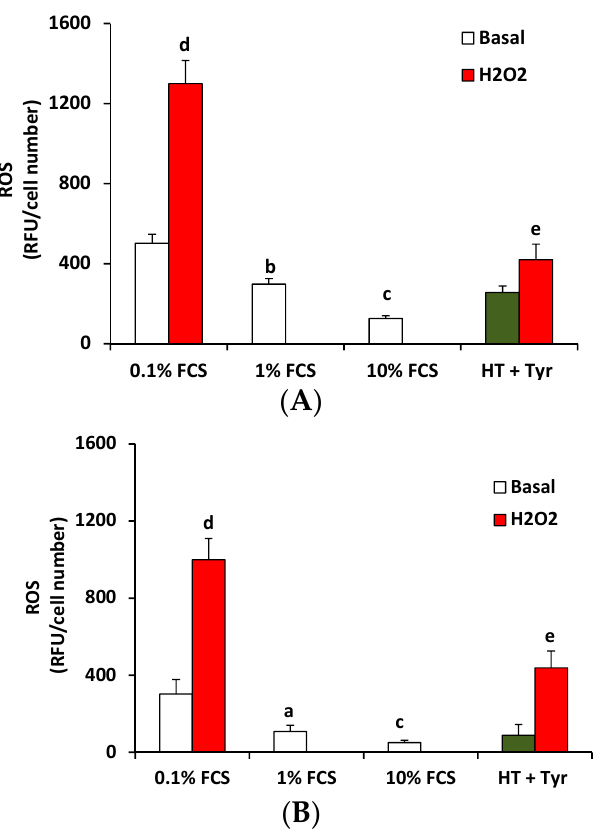
Figure 3. The HT + Tyr combination decreases reactive oxygen species (ROS) levels in HUVEC exposed to H 2 O 2 . HUVEC were stimulated with HT + Tyr (10 µM each, green bar) in 0.1% FCS for ( A ) 30 min or ( B ) 18 h and then exposed to H 2 O 2 (100 µM, 90 min). Data are expressed as relative fluorescent units (RFU)/cell number ( n = 3). a p < 0.05, b p < 0.01, c p < 0.001 vs. 0.1% FCS, d p < 0.001 vs. 0.1% FCS, e p < 0.001 vs. H 2 O 2 .